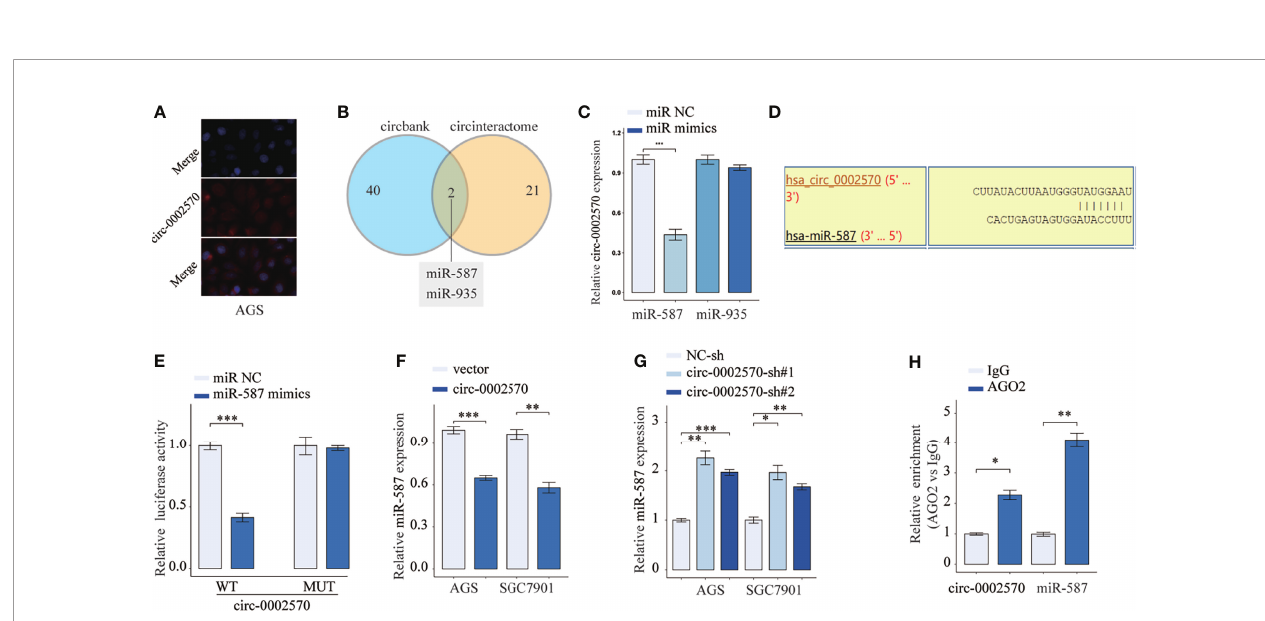
FIGURE 4 | Knockdown of circ-0002570 accelerates tumorigenesis in vivo . (A) Tumors derived from mice in two different groups were presented. (B, C) Tumor weight and volume were detected in tumor tissues of nude mice injected with circ-0002570-sh transfected AGS cells. (D) RT-PCR for the expression of circ- 0002570 in the collect tumor samples. (E) HE staining and IHC staining of Ki-67 in two groups. *** p <